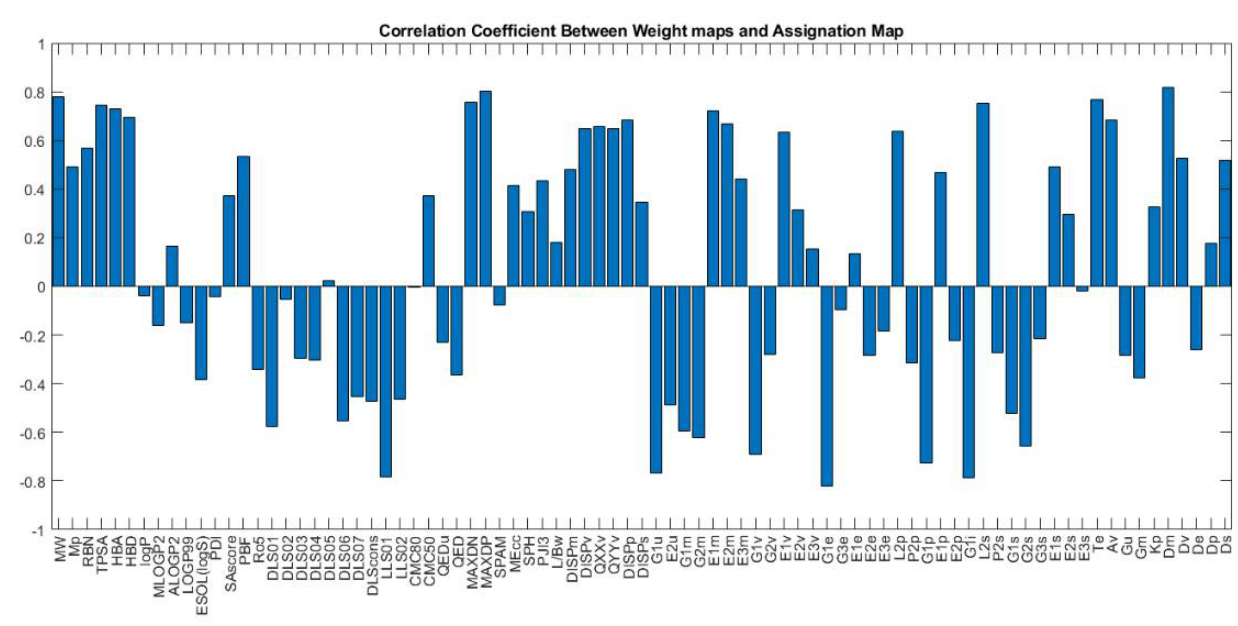
Figure 23. The correlation coefficient between each weight-map (corresponding to each descriptor) with the assignation map.